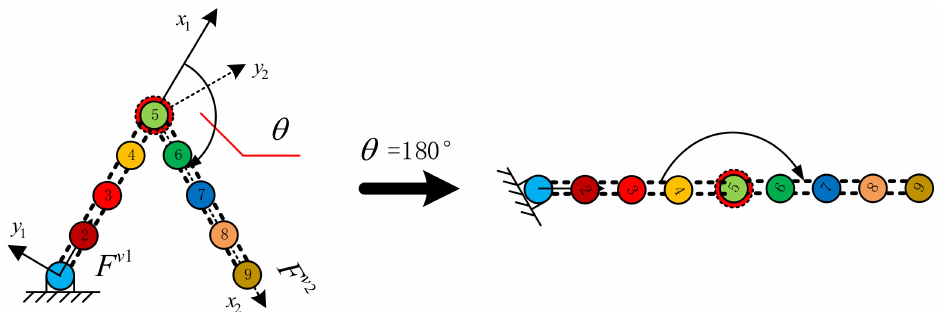
Figure 11. Predefined virtual linkage used in these two